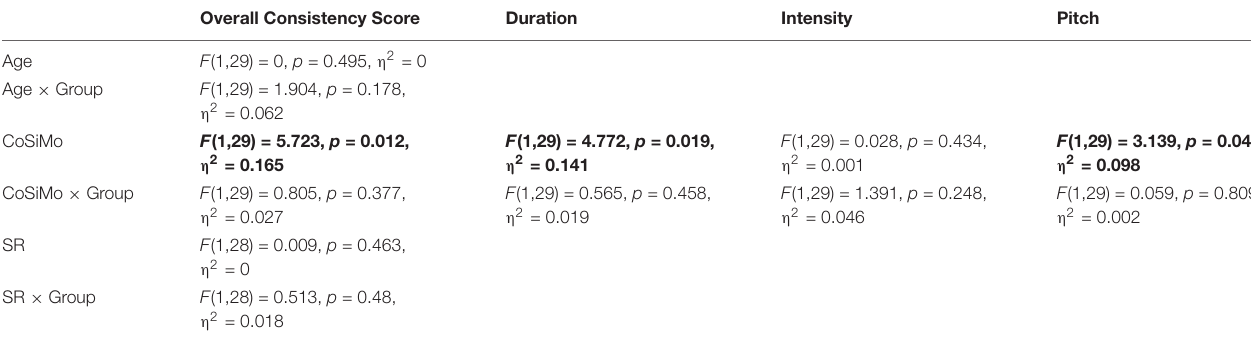
TABLE 2 | Impact of a set of predictors on Stress Perception parameters.